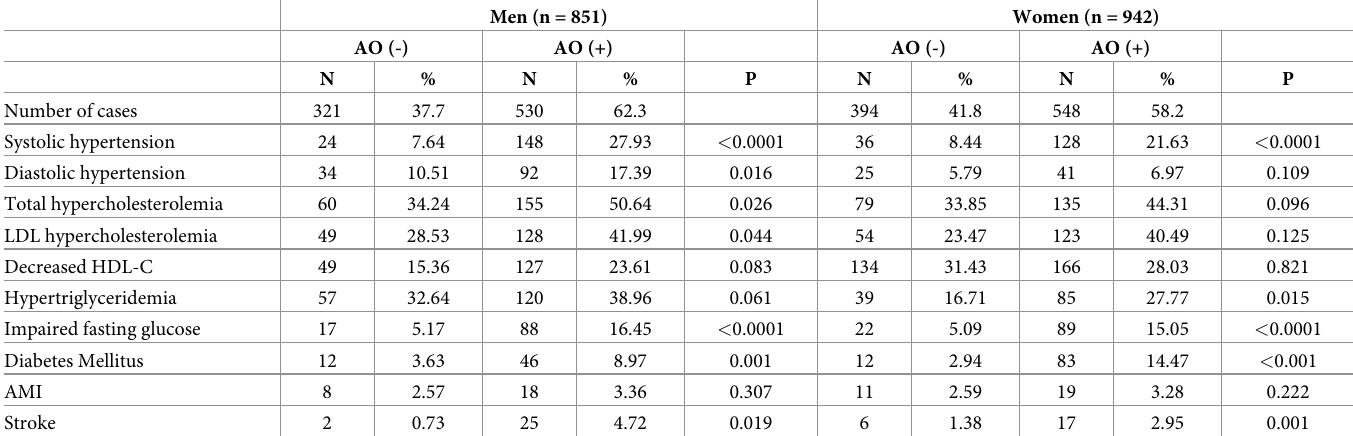
Table 2. Frequency of CVRF, AMI and stroke in overweight individuals (BMI: 25–29.99 kg/m 2 ) with AO.